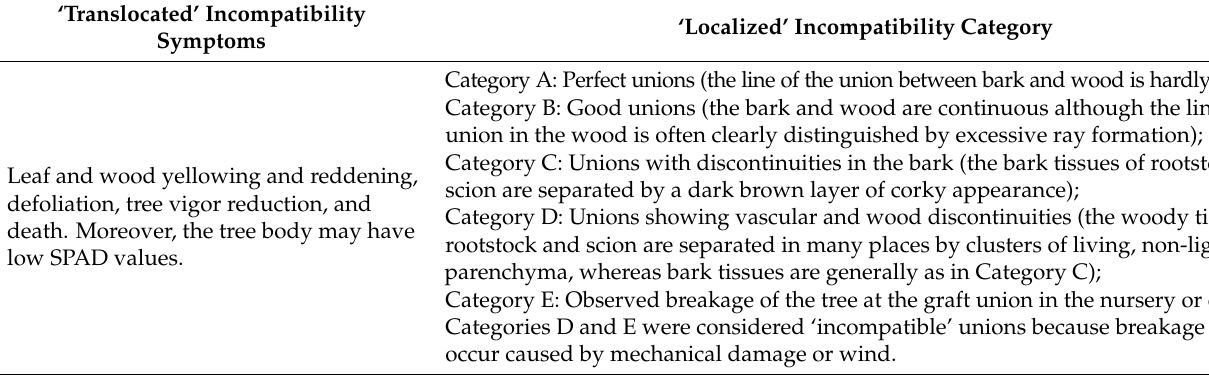
Table 1. ‘Translocated’ incompatibility and ‘Localized’